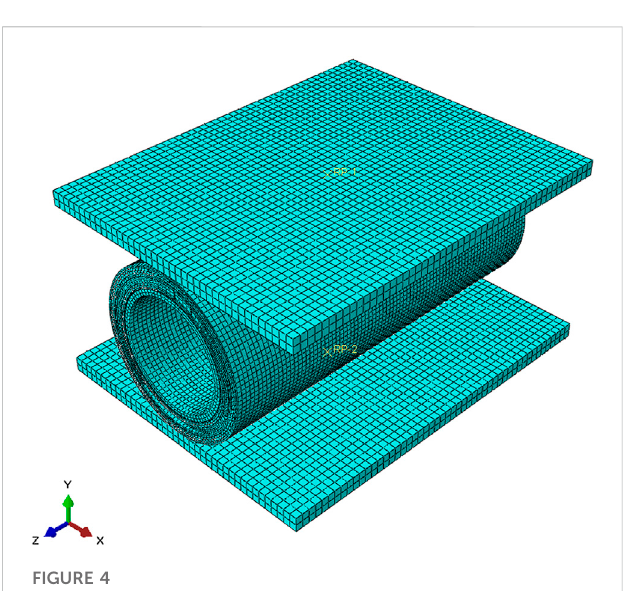
FIGURE 4 3D fi nite element model of the fi bre reinforced fl exible pipe and steel plates.